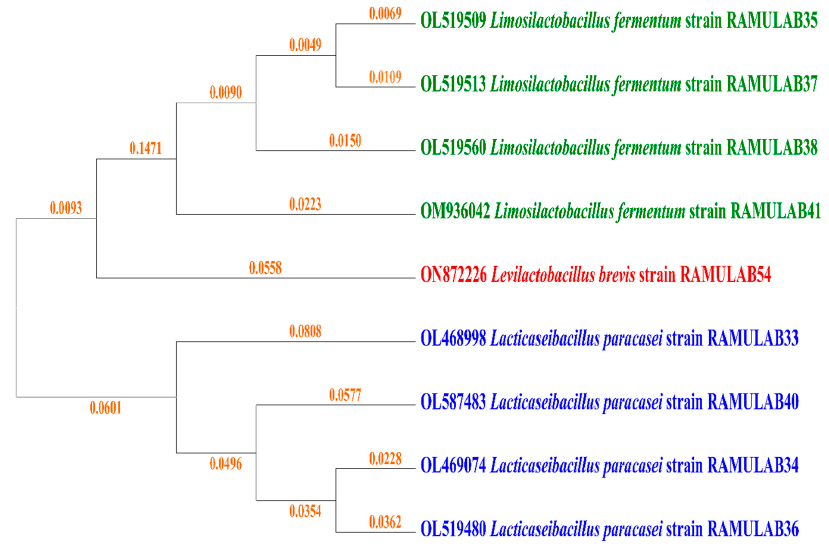
Figure 1. Phylogenetic tree comparison of strains isolated from fermented sugarcane juice based on maximum likelihood bootstrap analysis of 16S rRNA.